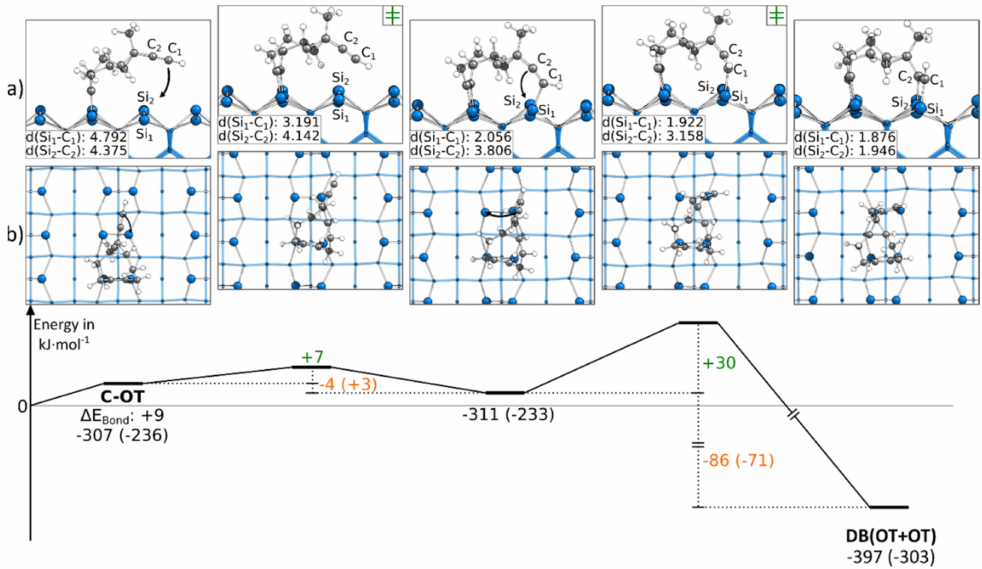
Figure 7. Reaction from a C-OT to a DB(OT+OT) structure, with side ( a ) and top ( b ) views of the minima and transition states. Electronic (Gibbs) bonding energies are stated for the minima. Activation energies ( ∆ E Act ) are shown in green, and electronic (Gibbs) reaction energies ( ∆ E React ) are shown in orange. All values are expressed in kJ · mol − 1 , and Si-C bond lengths are expressed in